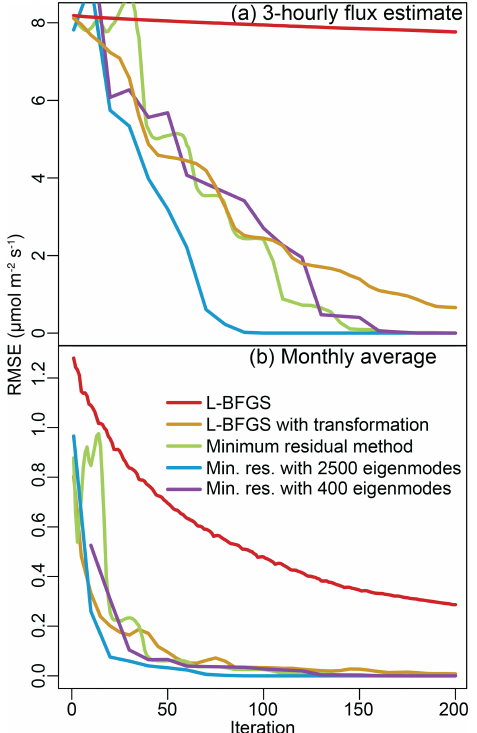
Figure 1. Root mean squared error (RMSE) relative to the di- rect solution for the 6-week case study. The top panel (a) displays RMSE calculated using each of the 1 . 05 × 10 6 flux grid boxes. The minimum-residual method with a preconditioner converges most quickly on the direct solution while L-BFGS shows poor conver- gence. We also average the 3-hourly posterior flux estimate to ob- tain a monthly averaged flux for each model grid box, and the error in this monthly average is displayed in panel (b) . The flux estimate, when averaged up to this aggregate monthly scale, converges more quickly to the direct solution than the individual 3-hourly